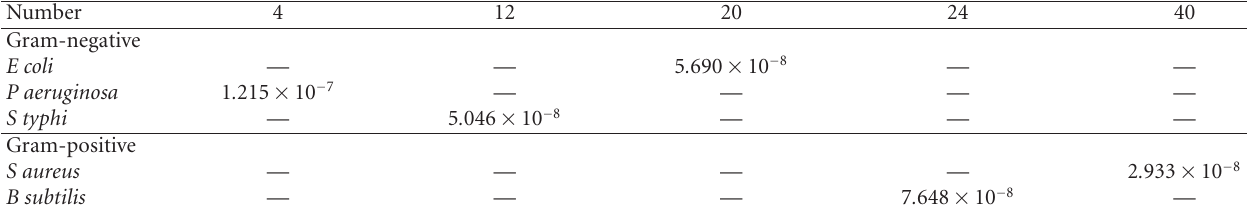
Table 5: Results of minimum inhibitory concentration (M/mL) of the selected compounds (4), (12), (20), (24), and (40) against selected bacteria.